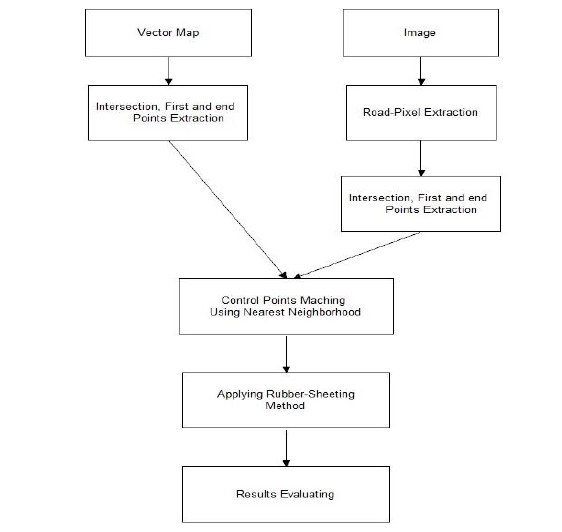
Figure 1 - Flowchart of automatic vector- image conflation